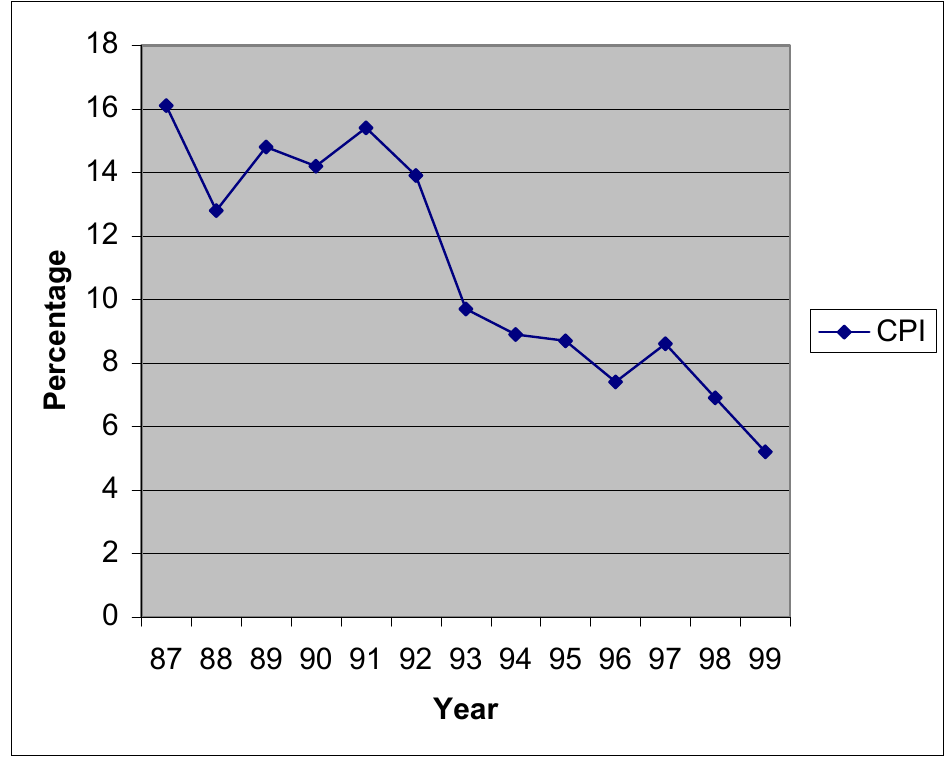
Figure 2: The Consumer Price Index (1987 –